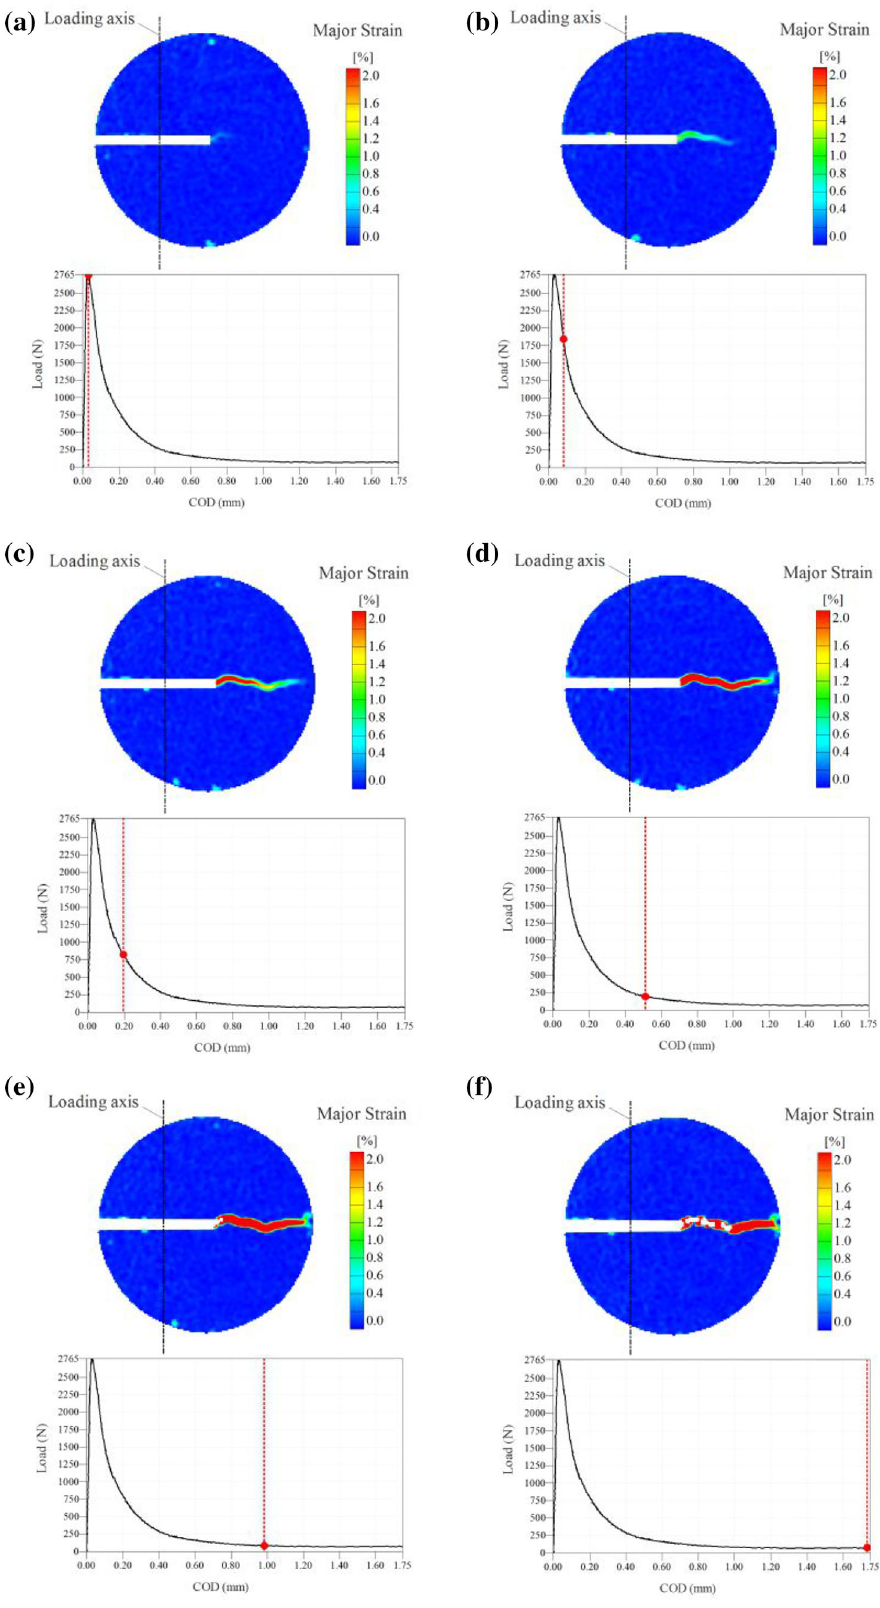
Fig. 11 a – f Crack path evolution during the MDCT test for one of the specimens